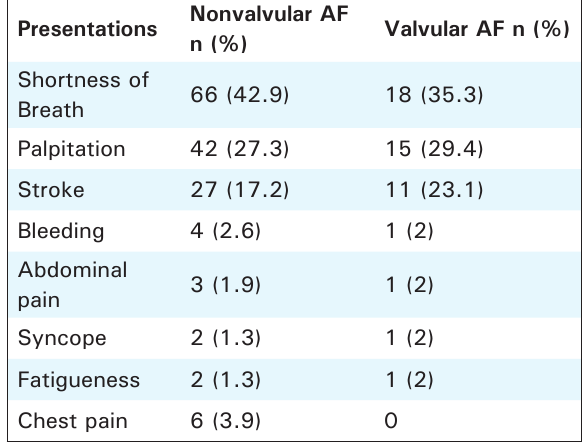
Table 2. Clinical